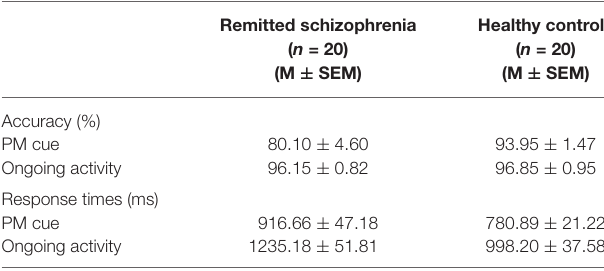
TABLE 2 | Accuracy (%) and response times (ms) for symptomatically remitted patients with schizophrenia and healthy